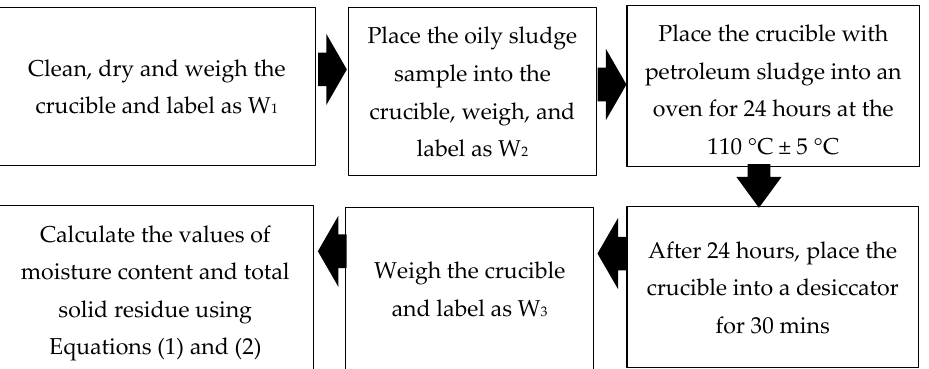
Figure 1. Process flow for the determination of moisture content and total solid residue.